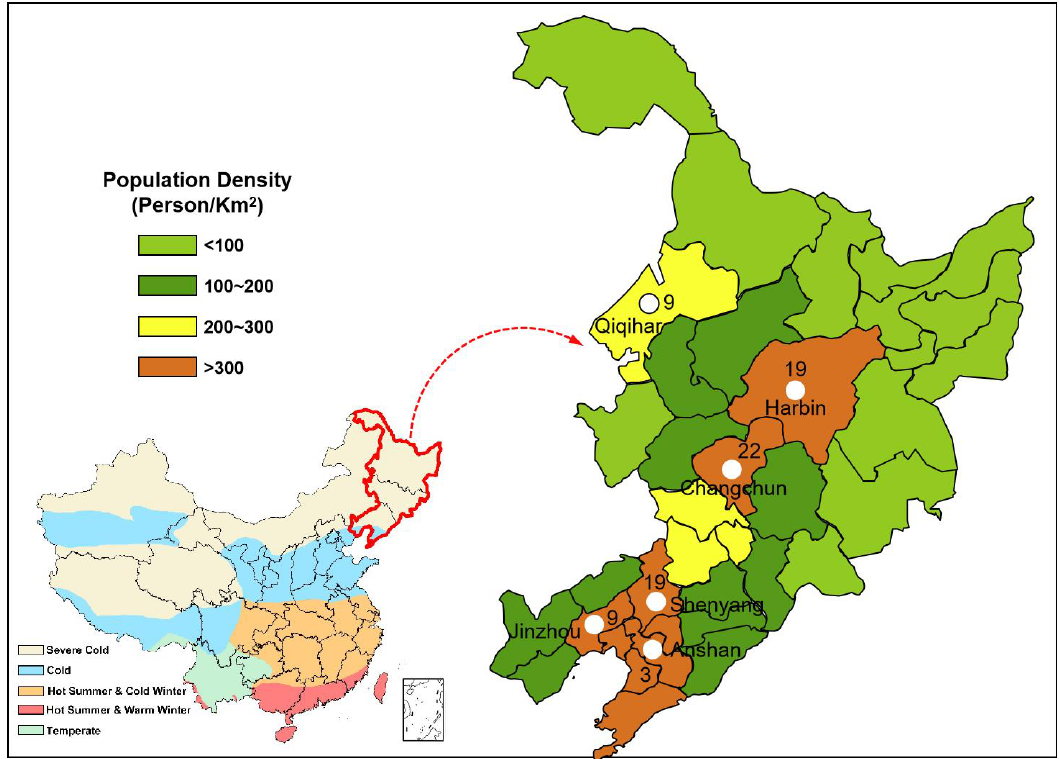
Figure 1. The population density of Northeast China and the number of investigated residential buildings.